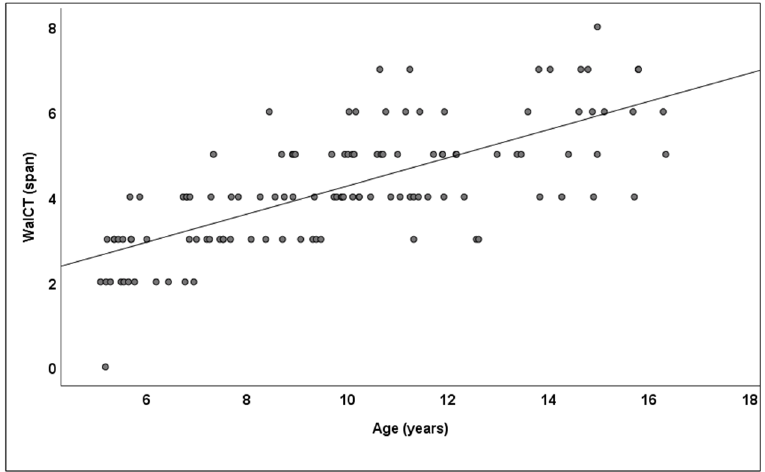
Figure 2. Topographical walking memory with respect to age in the entire study group.